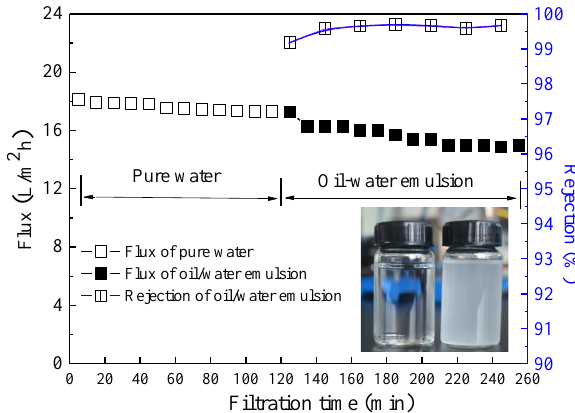
Figure 6. The PWF, oil–water emulsion flux and rejection of oil–water emulsion of the kaolin/CaAlg membrane. The digital photos of feed solution ( right ) and permeate solution ( left ).